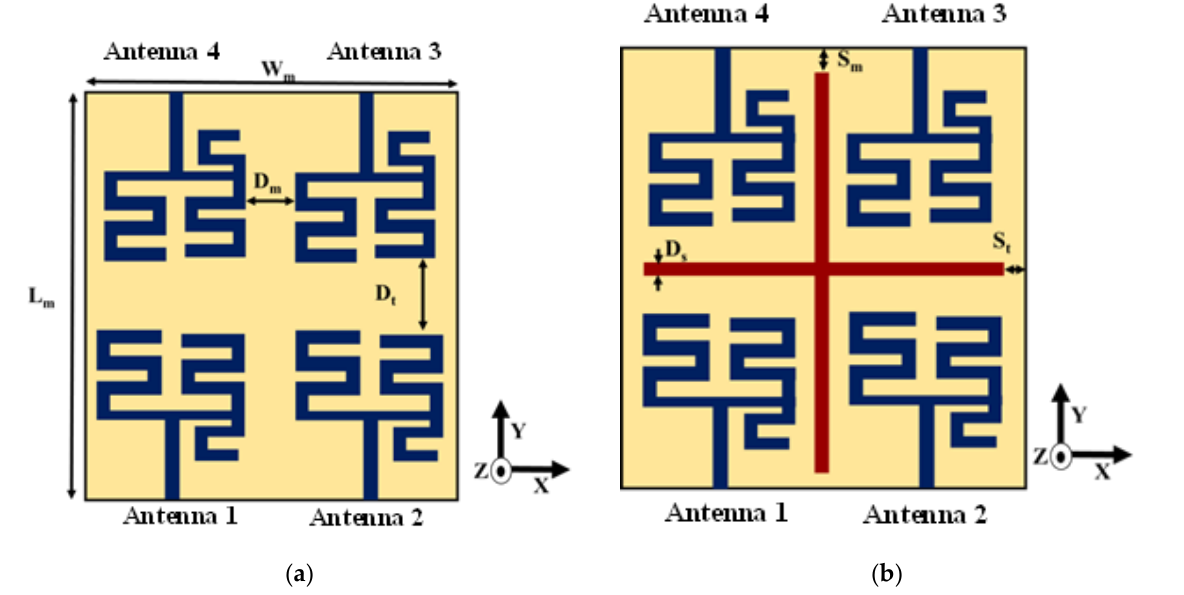
Figure 4. Schematic diagram of four element MIMO antenna ( a ) without parasitic cross microstrip line and ( b ) with parasitic cross microstrip line. Table 2. Design parameters of four elements MIMO antenna.